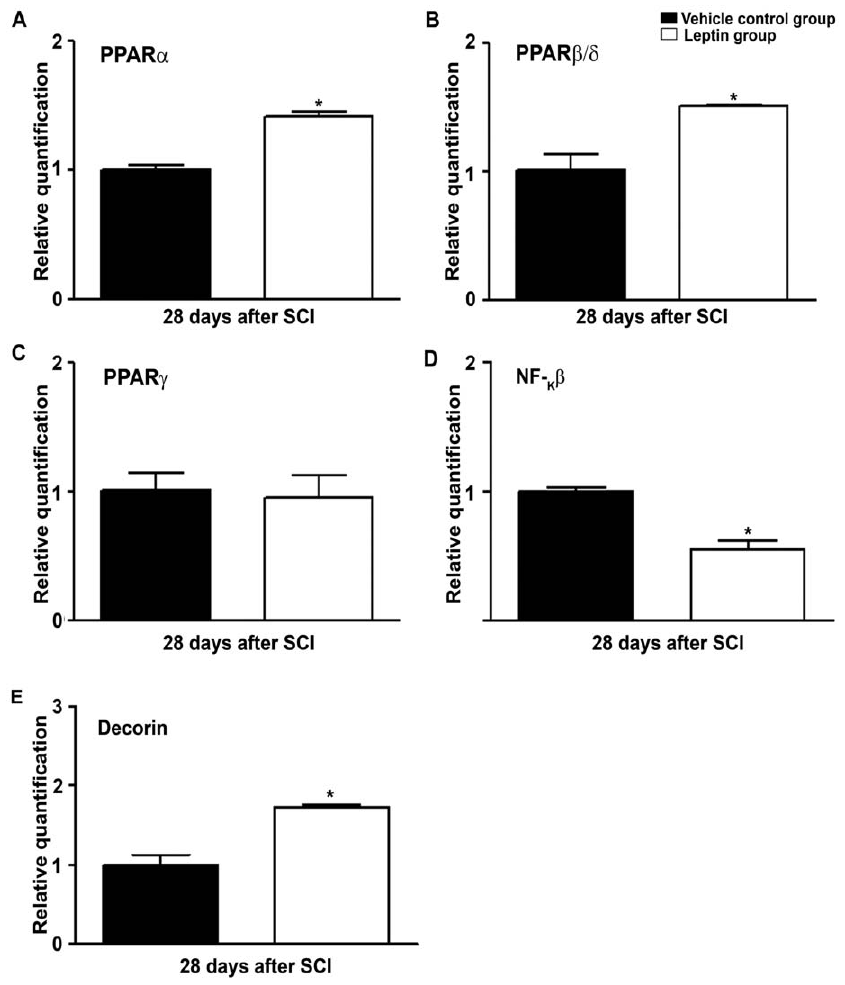
Figure 10. The effect of leptin treatment on PPARs, NF-k b and decorin in the chronic phase of SCI. The expression of PPAR a (A), PPAR b / d (B), PPAR c (C), NF- k b (D) and decorin (E) were quantified by RT-qPCR 28 d post-SCI. As shown, a significant up-regulation of PPAR a and PPAR b / d mRNA expression was observed in leptin-treated animals. No differences were detected in the mRNA expression of PPAR c when compared with vehicle-treated controls. Moreover, a significant decrease in NF- k b mRNA expression and an increase in decorin mRNA expression were observed in leptin-treated animals. The values in A–E represent the mean 6 SEM; * p , 0.05 versus the vehicle-treated controls.